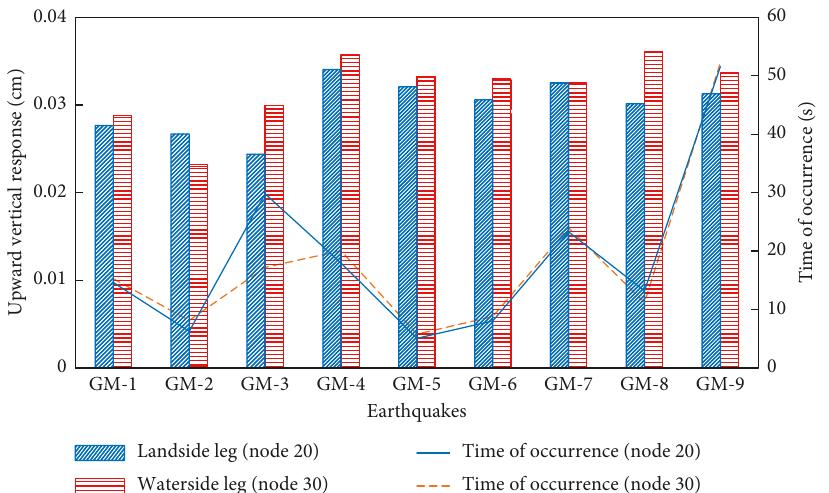
Figure 12: Upward vertical responses/displacements of the landside and waterside legs versus time of occurrence due to dynamic analysis (gravity analysis not